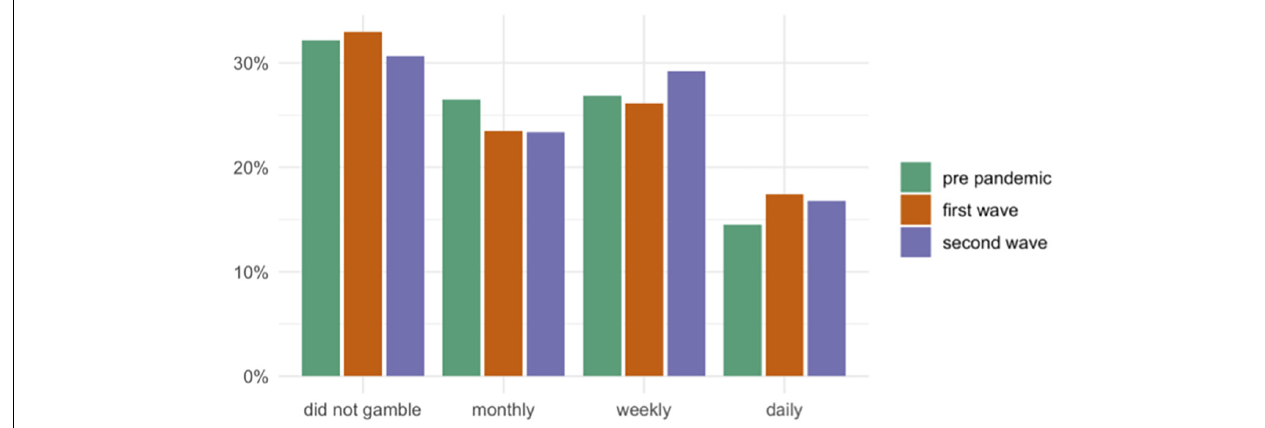
FIGURE 1 | Highest gambling frequency in a game type per time period. Pre-pandemic N = 283, first wave N = 267 and second wave N =